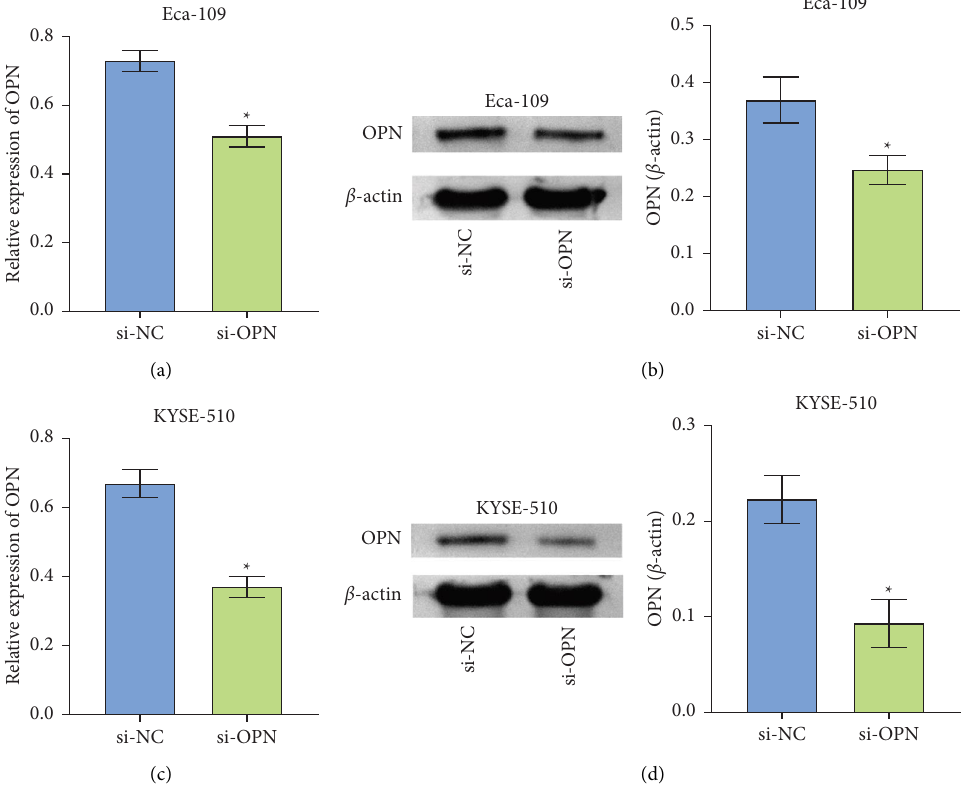
Figure 2: Te expression level of OPN was suppressed. (a) OPN mRNA levels in Eca-109 cells after OPN silencing. (b) Te level of OPN protein of Eca-109 cells in si-NC and si-OPN groups. (c) Te expression of OPN mRNA in KYSE-510 cells decreased after OPN silencing. (d) Te level of OPN protein in KYSE-510 after OPN silencing. ∗ P < 0 . 05 compared with si-NC.